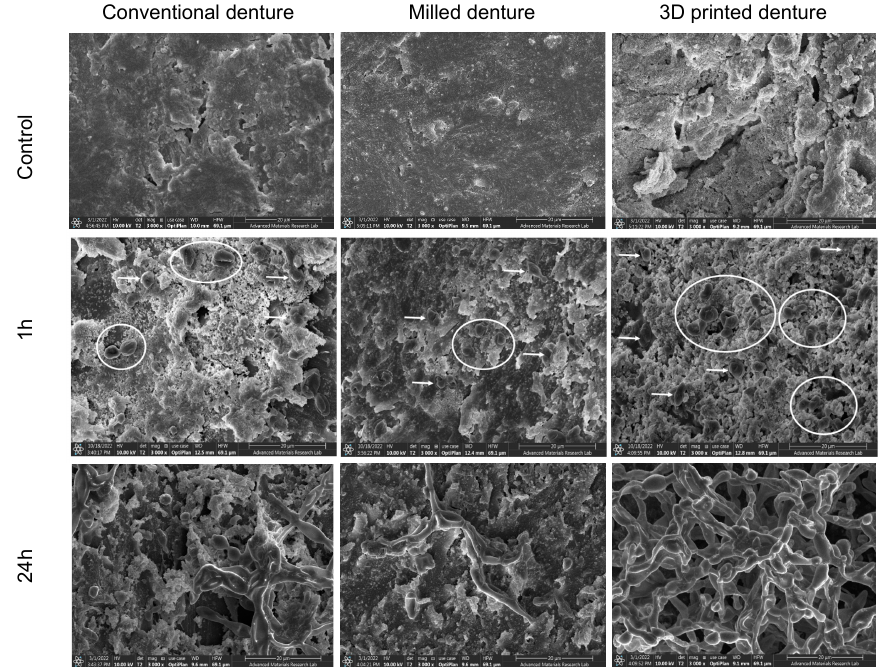
Figure 4. FESEM showing denture surfaces topographies (control) and C. albicans adherence (1 h) and biofilm growth (24 h) in all test specimens (magnification 3000 × , scale bar: 20 um). White arrows show adherent separate ovoid fungal cells and white circles indicate clusters of cells presenting the initial stage of bio fi lm formation.